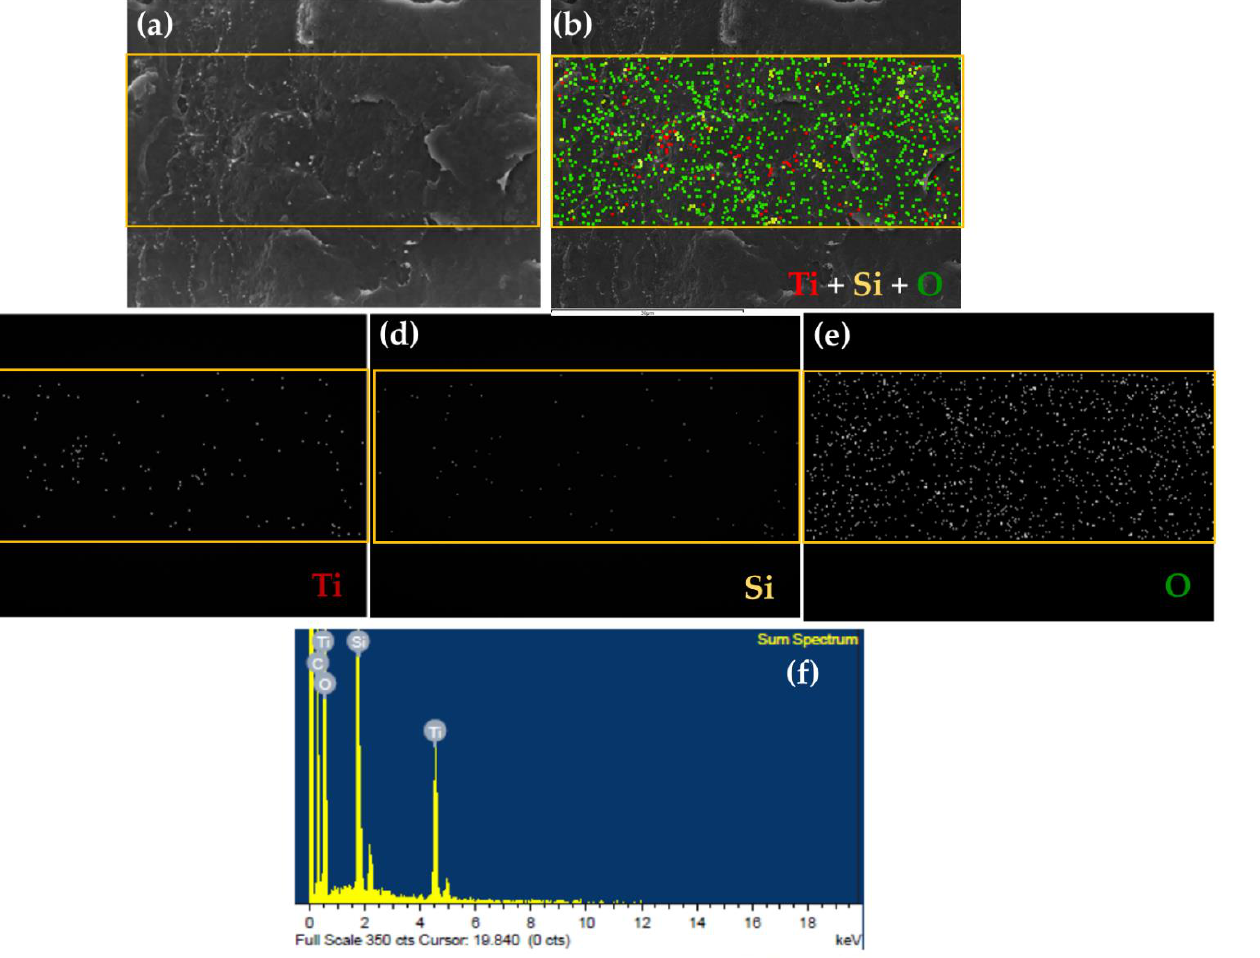
Figure 6. ( a ) SEM images ( b ) over all elements in the PLA/Ti 70 Si 30 composite and the corresponding elemental mapping analysis of ( c ) Ti, ( d ) Si, ( e ) O, and ( f ) EDX spectra.